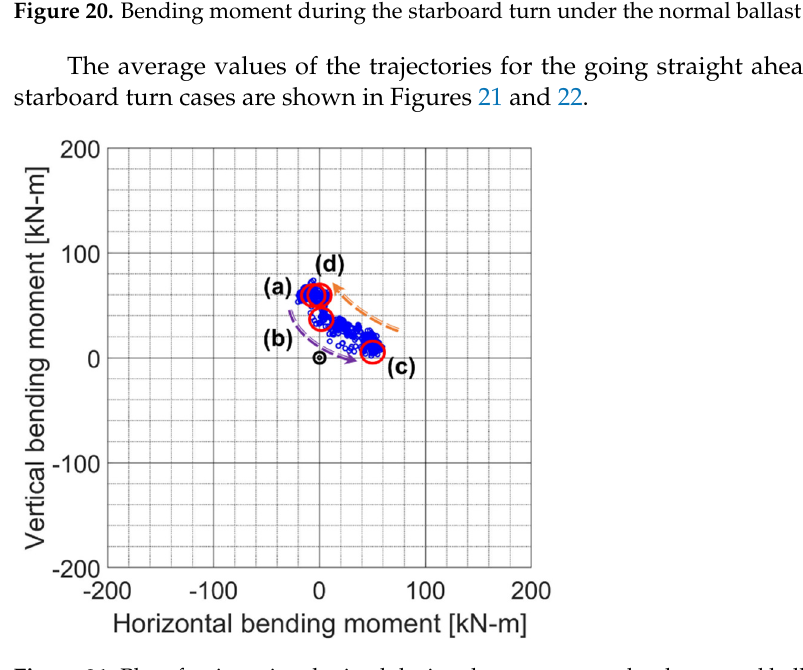
Figure 21. Plot of trajectories obtained during the port turn under the normal ballast condition. Stage (a): Rudder angle 0-degree: NCR straight going (begin). Stage (b): Rudder angle changes from 0 to 12-degree (port). Stage (c): Rudder angle 12-degree: ship’s heading is gradually changing. Stage (d): Rudder angle 0-degree: NCR straight going (end).